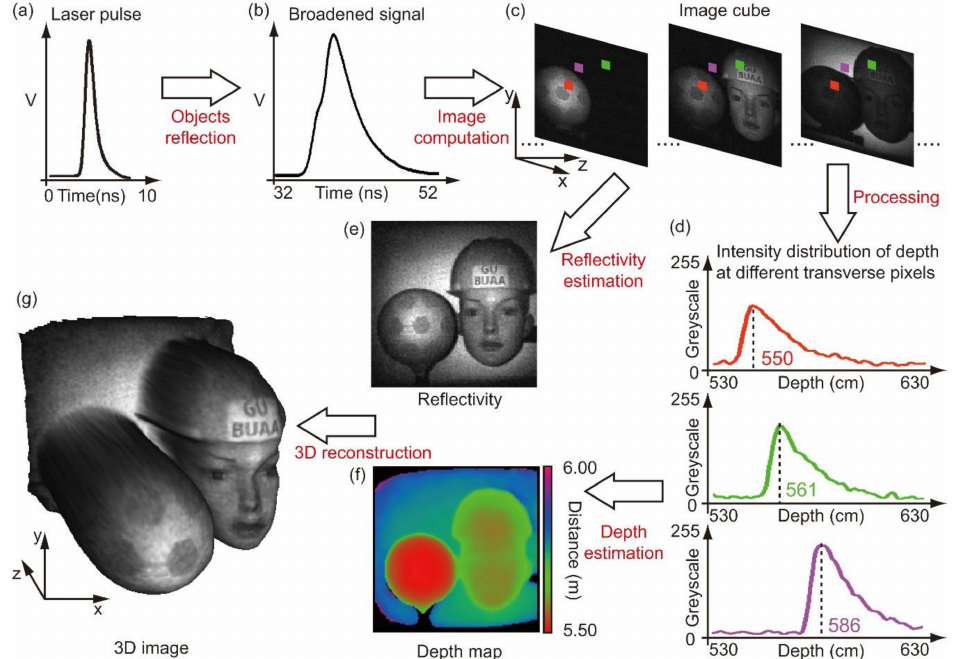
Figure 4. Overview of the image cube method: ( a ) The illuminating laser pulses back-scattered from a scene are measured as ( b ) broadened signals; ( c ) an image cube, containing images at different depths, is obtained using the measured signals; ( d ) each transverse location has an intensity distribution along the longitudinal axis, indicating depth information; ( e ) reflectivity and ( f ) a depth map can be estimated from the image cube, and then be used to reconstruct ( g ), a 3D image of the scene. Experimental data used in this figure is from the work of